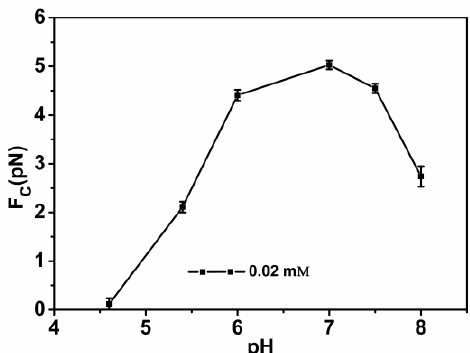
Figure 5. DNA condensing force as a function of the different pHs of solutions with a fixed chitosan concentration (20 µM).